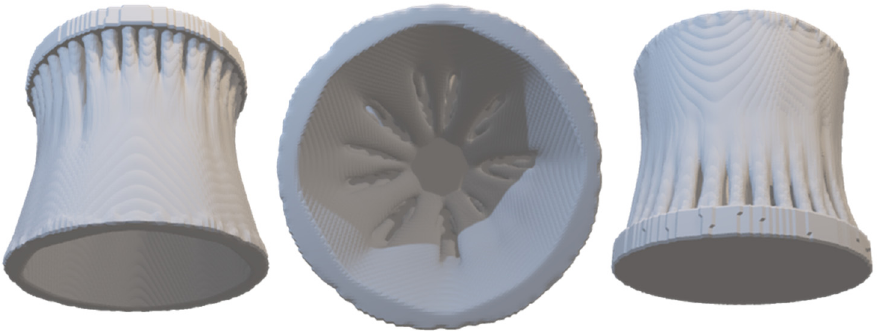
Figure 7. Bendsoe and Sigmund Optimization Model.